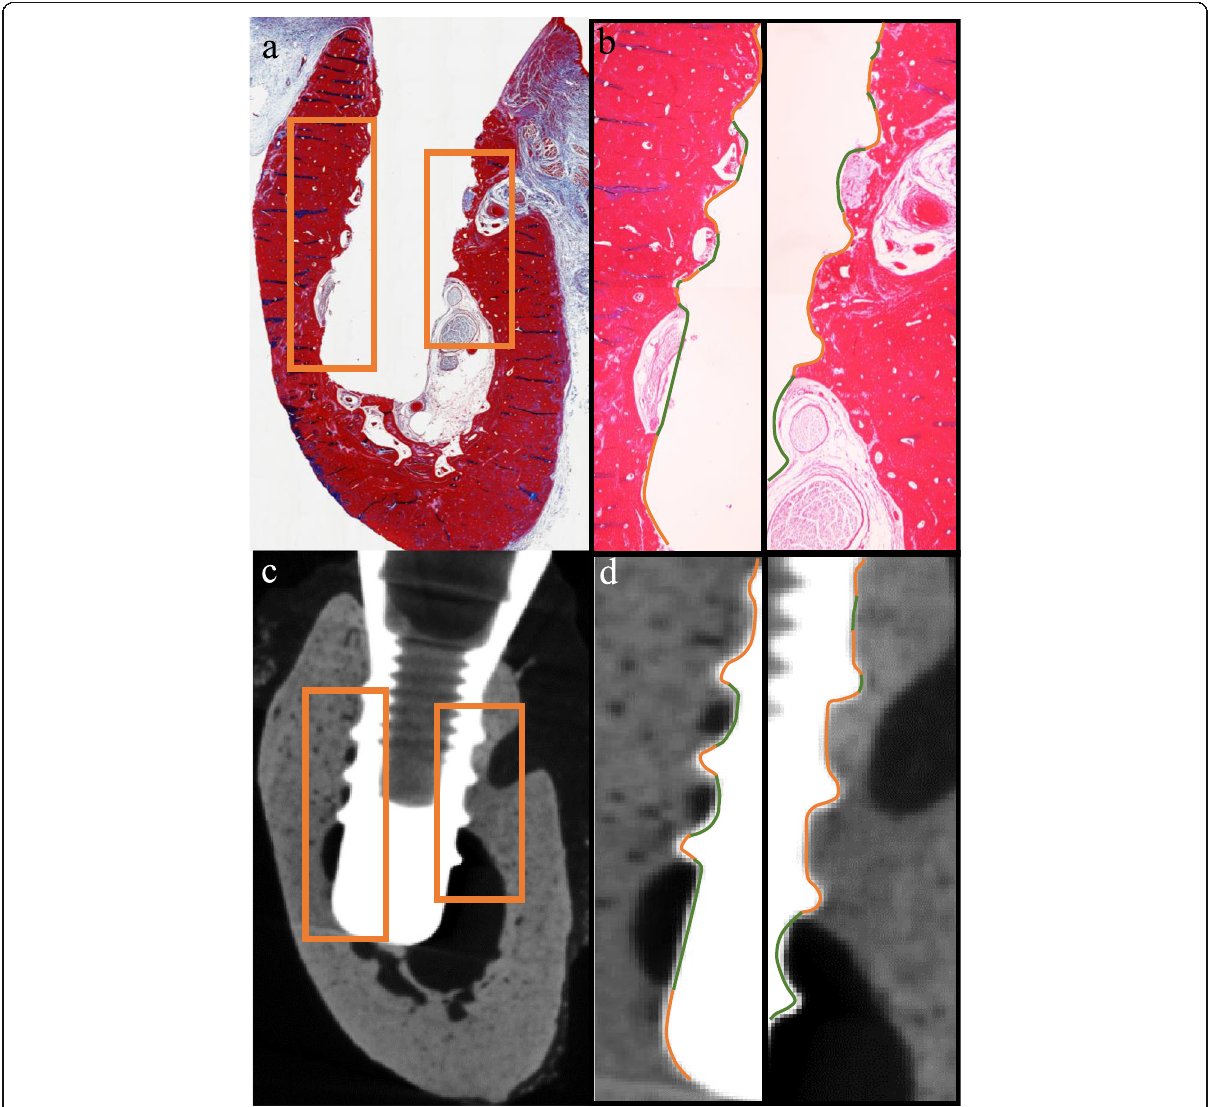
Fig. 2 Matching sections of histology and micro-CT image and BIC% measurement. a , c Matching bucco-lingual images of histology and micro- CT. b , d Magnification of the orange rectangle in a and c (× 40). Orange line is the bone-to-implant contact; green line is the implant